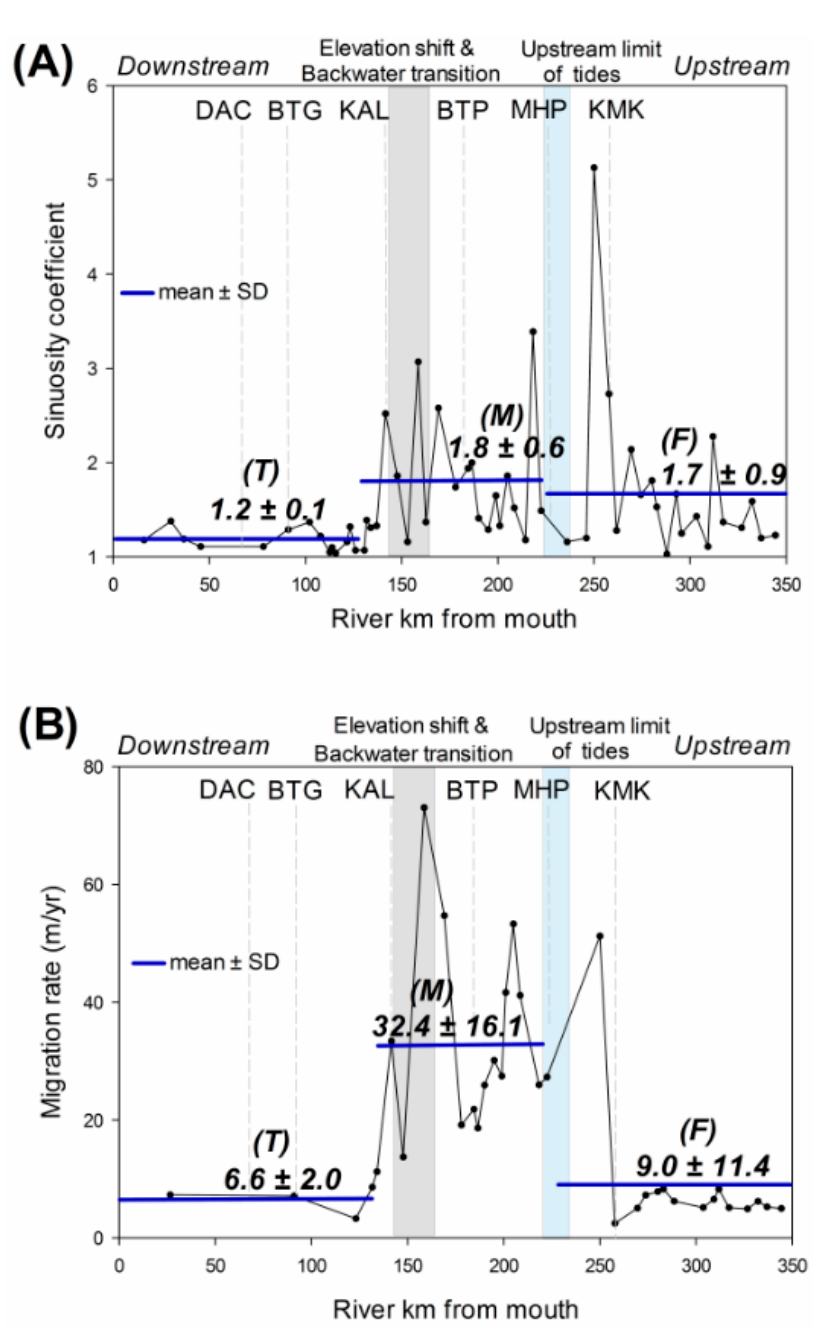
Figure 4. Trends in channel morphodynamic properties as a function of distance from the river mouth, including: ( A ) present-day channel sinuosity and ( B ) meander bend migration rates between 1972 and 2015. Average ± standard deviation (SD) values for tidal (T), mixed tidal-fluvial (M), and fluvial (F) hydrodynamic zones are indicated by blue horizontal lines. The elevation shift and backwater transition are displayed as a shaded envelope because they occur over an area of the river rather than at a single point. Similarly, the upstream limit of tidal influence is represented as an envelope because the limit depends on the magnitude of river discharge.